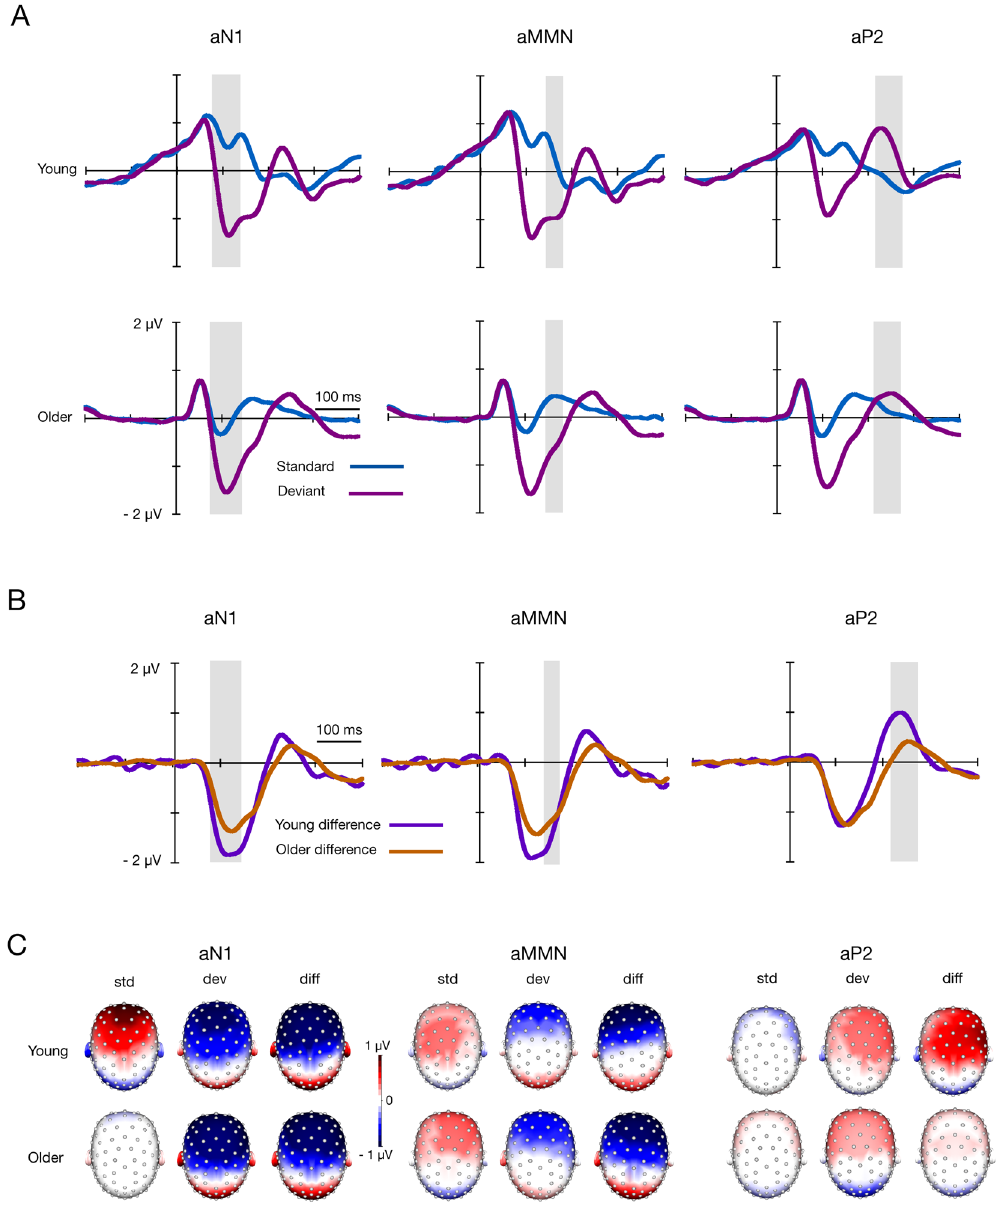
Figure 2. ( A ) Grand-averaged ERPs to auditory standard and deviant stimuli for young and older adults and ( B ) the differential waveforms (standard minus deviant) for young and older adults. Waveforms represent averages of the electrode pools applied in the analyses. The grey area shows the latency range of 88–138 ms for aN1, of 139–189 ms for aMMN, and of 208–280 ms for aP2, from where the averaged amplitude values were extracted to analyse each ERP component. ( C ) The scalp voltage distributions of responses to standard (std) and deviant (dev) stimuli and differential responses (diff) (deviant minus standard). The topography maps are shown as average voltages from 88–138 ms for aN1, 139–189 ms for aMMN, and 208–280 ms for